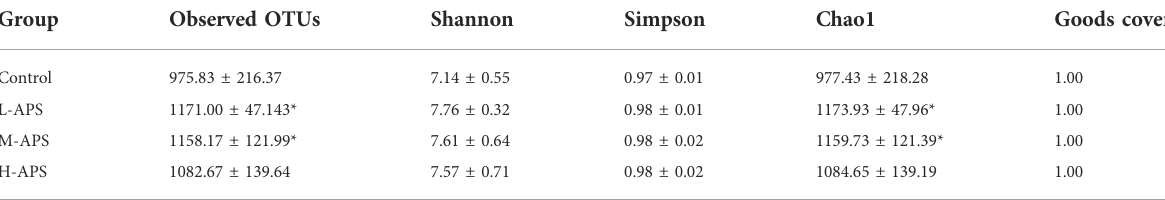
Note: * p < 0.05 vs. control.